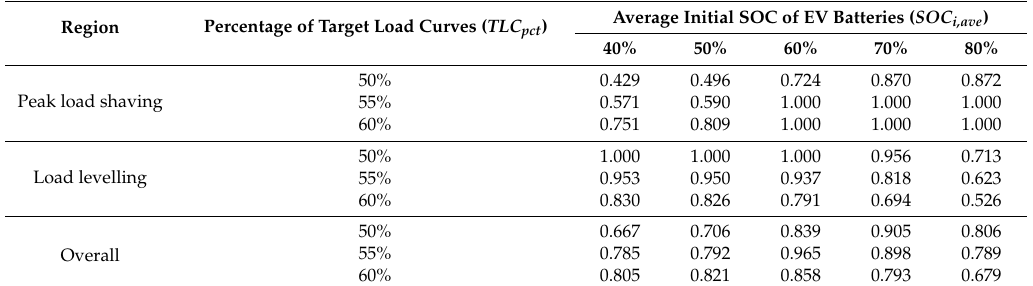
Table 1. Performance Index of the V2G optimization algorithm under various scenarios.